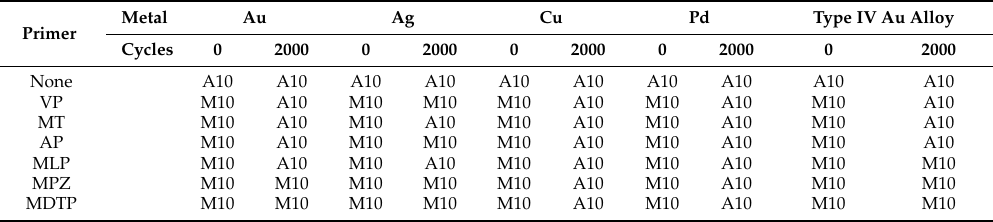
Table 4. Failure mode distribution in the experimental groups (number of